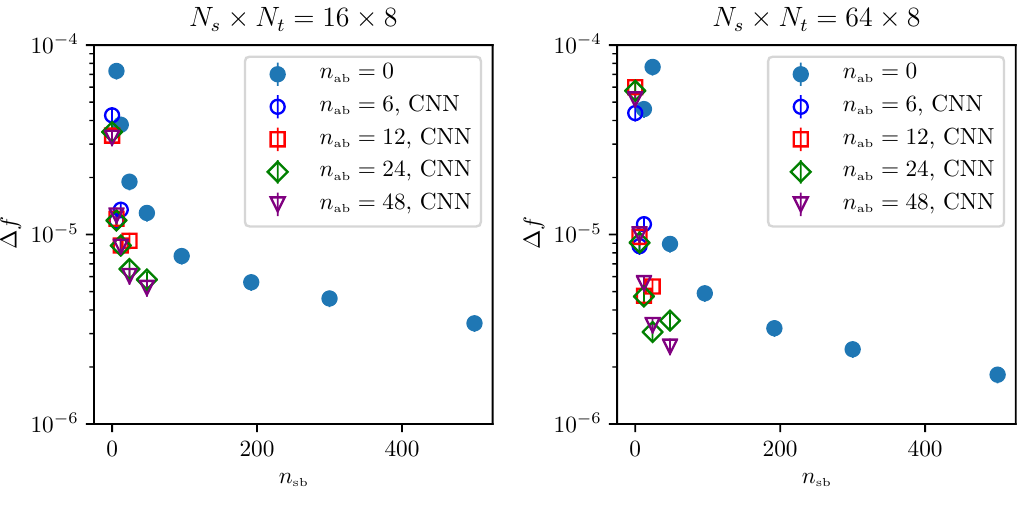
Figure 2 . Error on the free energy density a 2 f for various flow architectures from 2 × 10 5 in- dependent measurements. Results for 16 × 8 lattices (left-hand-side panel) and 64 × 8 lattices (right-hand-side panel) at κ = 0 . 2 , λ = 0 . 022 . The error on the error is calculated with a jackknife